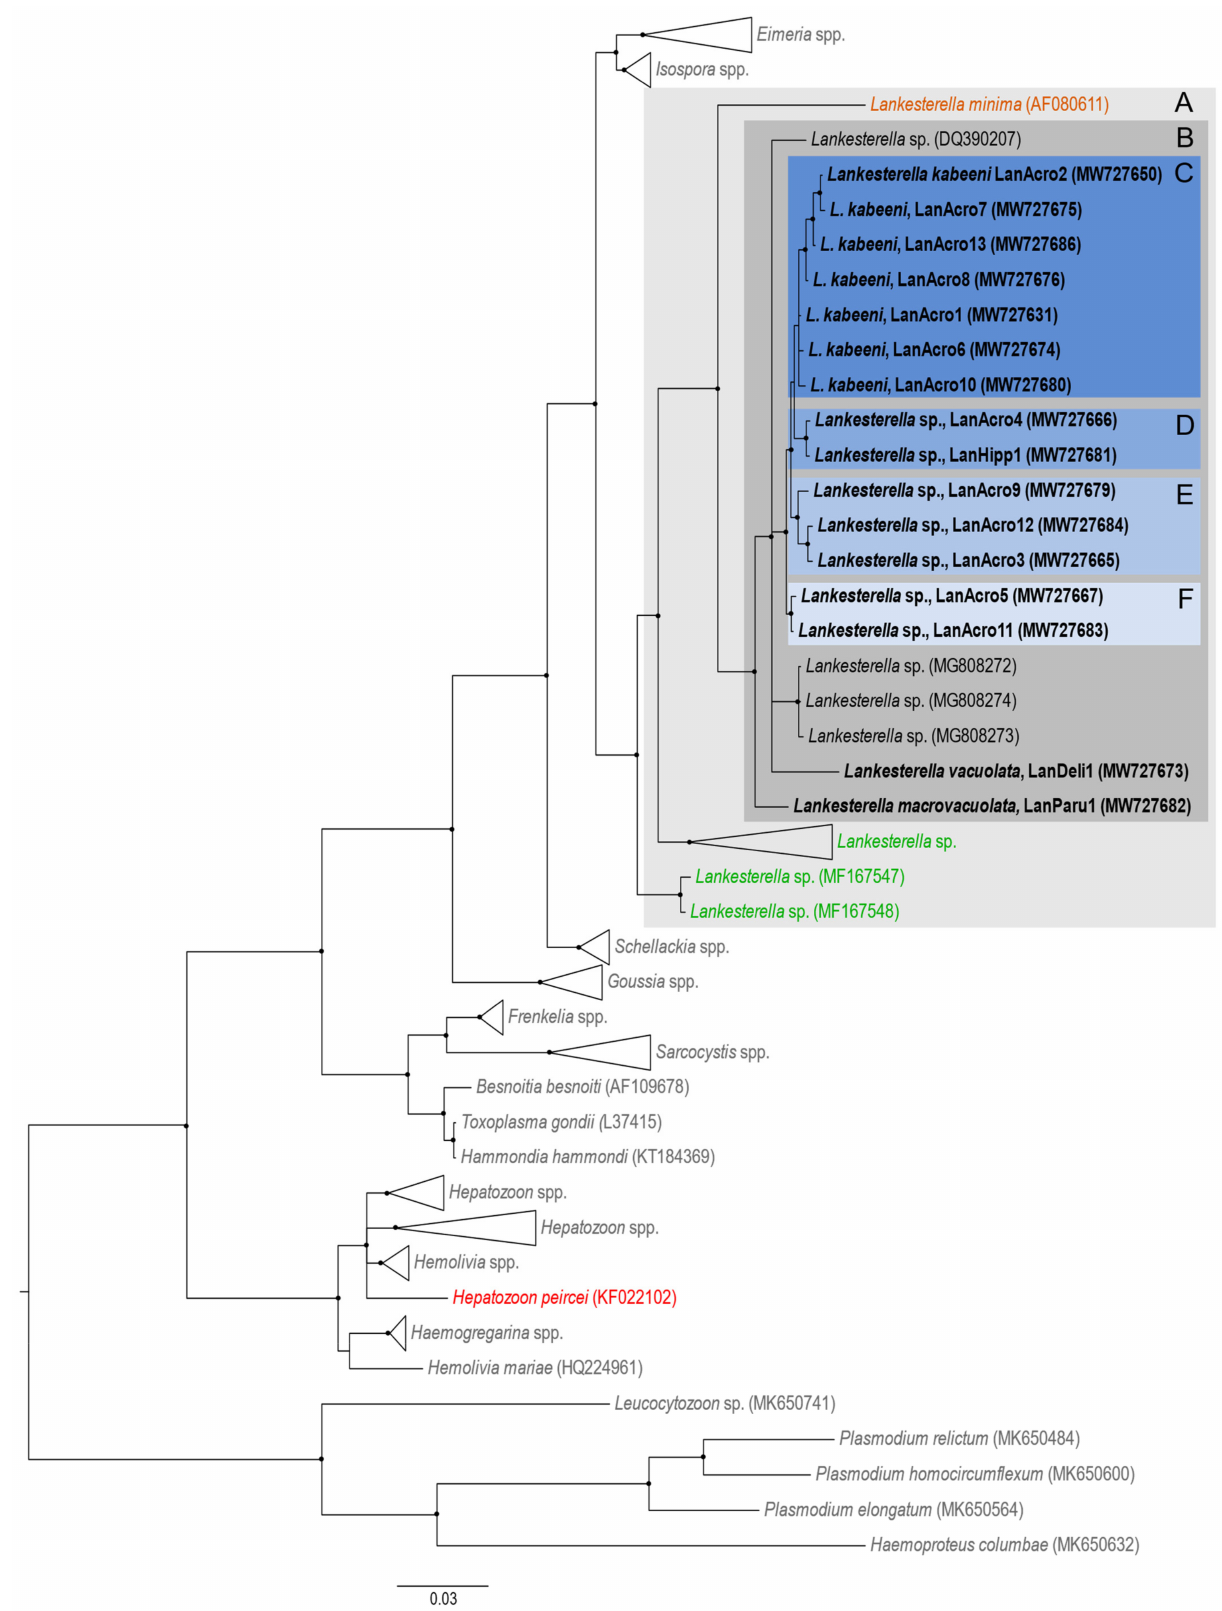
Figure 1. Bayesian inference tree of partial 18S rRNA gene sequences of Lankesterella parasites. Haemosporidian parasite DNA sequences ( Plasmodium and Haemoproteus ) were used as outgroup. Lankesterella DNA sequences from birds (given